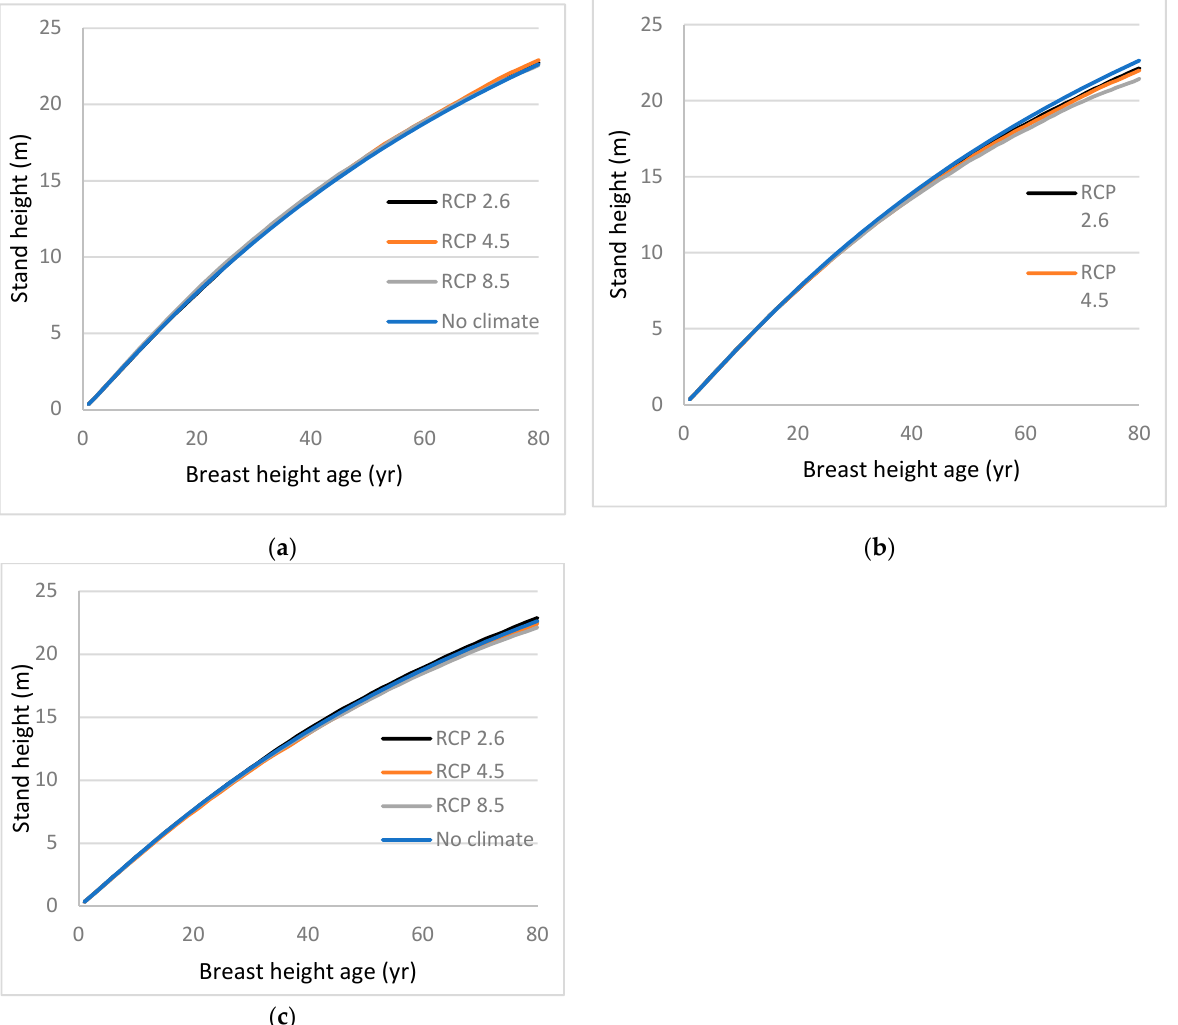
Figure 3. Stand height profiles for black spruce trees generated using projected values of climate variables for the period 2021 to 2080, assuming climate remains stable (no climate) or warms (RCPs 2.6, 4.5, and 8.5), in Equation (3) for ( a ) eastern (near Sudbury), ( b ) central (near Hearst), and ( c ) western (near Dryden) Ontario, Canada. Climate variables were projected for locations close to sample sites using three emissions trajectories known as representative concentration pathways (RCPs).